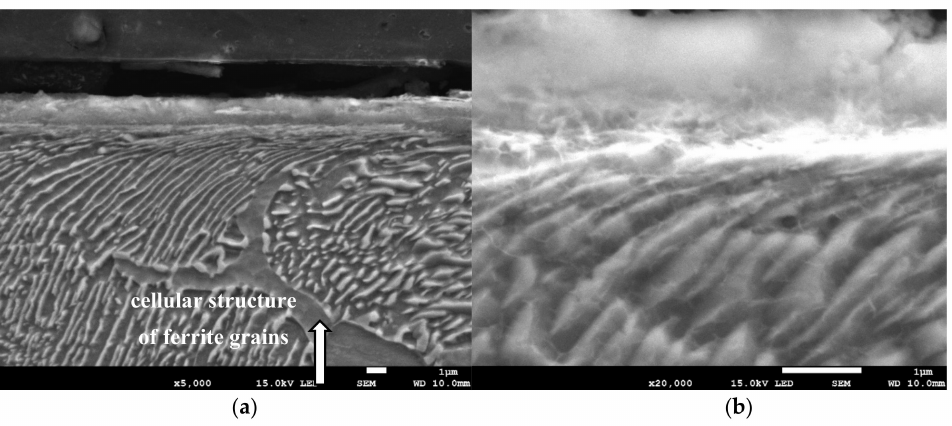
Figure 6. The microstructure of the surface layer after grinding to a depth of 20 µ m: ( a ) Deformation of pearlite and ferrite grains in the direction of peripheral speed—cellular structure of ferrite grain is depicted by an arrow, ( b ) scale with heterogeneous structures on the deformed